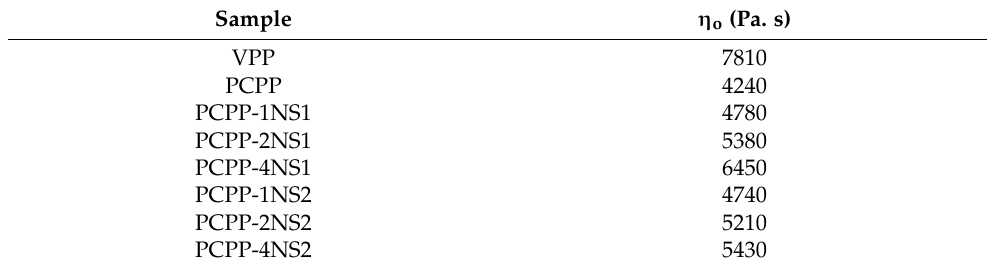
Table 3. Zero-shear rate viscosity of the samples. Sample η o (Pa. s) VPP 7810